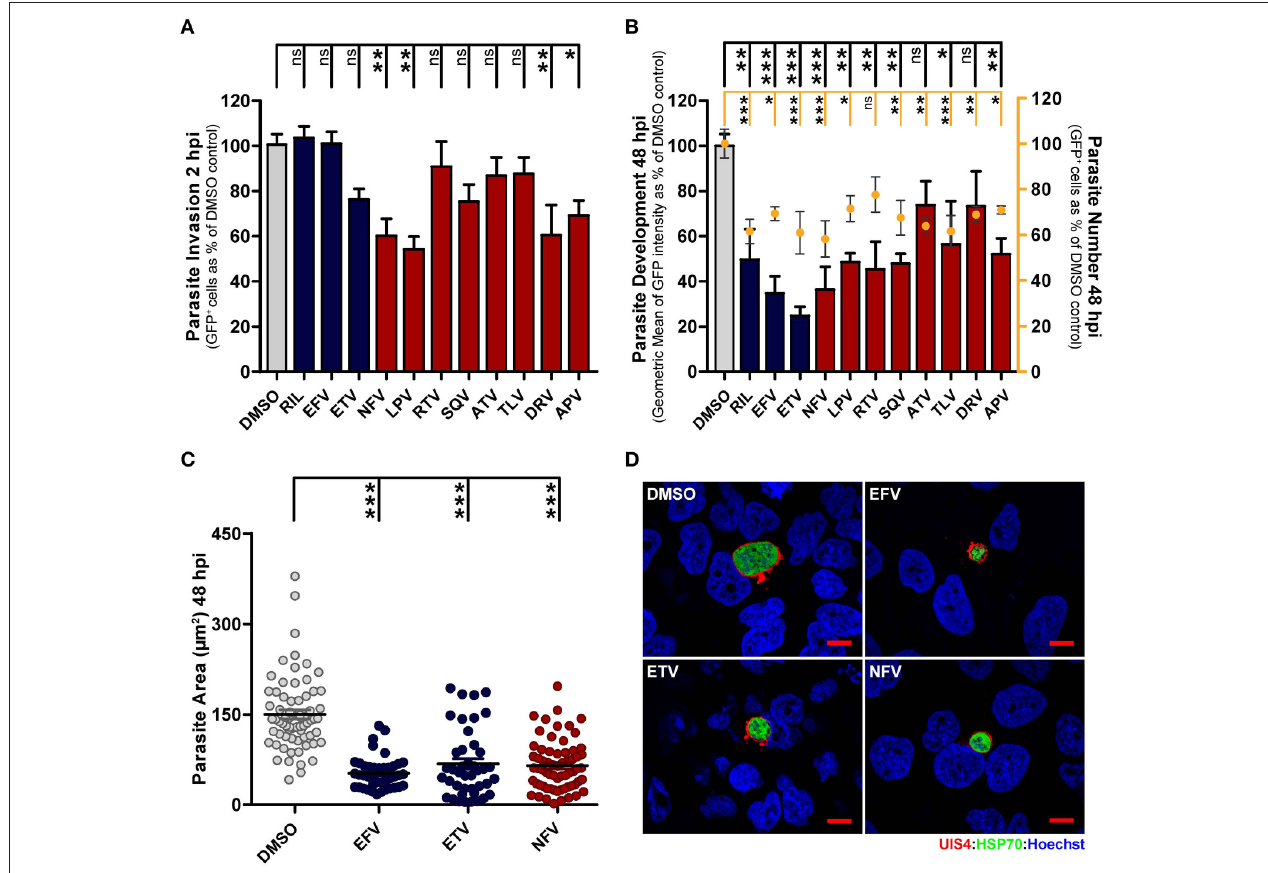
FIGURE 1 | Antiretroviral drugs inhibit Plasmodium hepatic infection in vitro . (A,B) HuH7 cells were infected with green fluorescent protein (GFP)-expressing P. berghei sporozoites. The culture medium of HuH7 cells was replaced by medium containing the IC50 concentration of selected drugs 1 hour prior to infection or 2 hpi, for invasion and development assays, respectively. (A) Cell invasion was quantified by flow cytometry by determining the percentage of GFP + cells at 2 hpi. (B) Percentage of infected cells (dots) and parasite development (bars) were assessed by determining the percentage and fluorescence intensity of GFP + cells at 48 hpi, respectively. (C) Parasite development in cells treated with EFV, ETV and NFV was also assessed by quantification of EEF area by immunofluorescence microscopy. (D) Representative immunofluorescence microscopy images show P. berghei hepatic forms treated with the IC50 concentrations of EFV, ETV and NFV or with DMSO (control) from 2 to 48 hpi. Immunofluorescence microcopy employed antibodies against Pb UIS4 (a parasitophorous vacuole membrane (PVM) protein, in red), Pb HSP70 (a heat shock protein that localizes to the parasite soma, in green), and the nuclear stain Hoechst (in blue). Scale bars, 10 µ m. Plots represent the mean values of at least three independent experiments with error bars indicating SEM. One-way ANOVA with post-test Dunnett. ns, not significant, * p < 0.05, ** p < 0.01, *** p < 0.001. Light gray bars or circles in panels (A–C) correspond to solvent controls, blue bars or circles correspond to NNRTIs, and red bars or circles correspond to